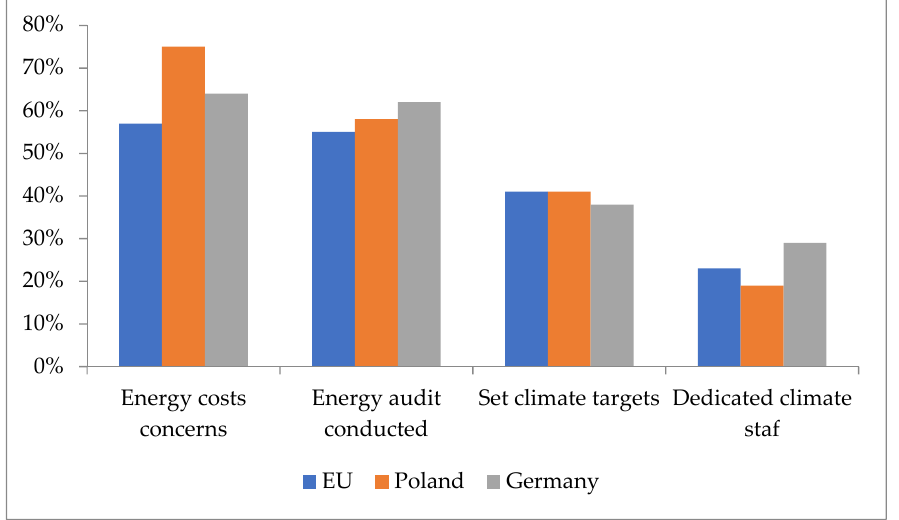
Figure 7. Characteristic features of climate change in the opinion of Poland and Germany compared with the European Union.